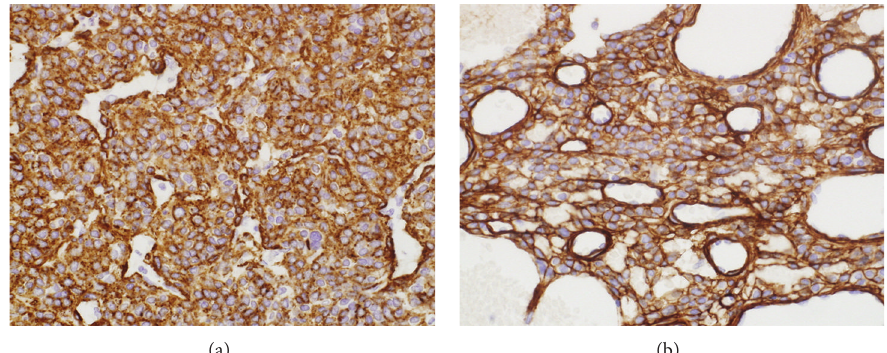
Figure 3: Immunohistochemistry of excised intestinal ileum tumor. (a) Tumor cells are positive for alpha smooth muscle actin ( 𝛼 -SMA). (b) Uniform pericellular type IV collagen